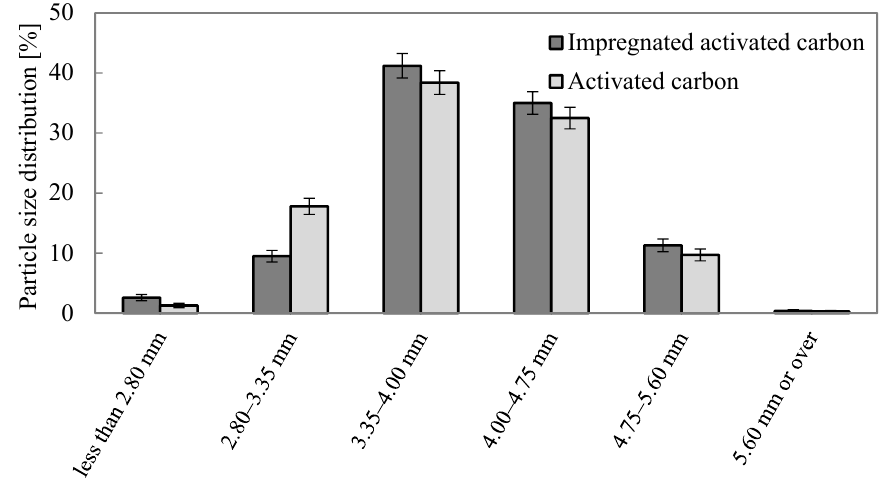
Figure 3. The particle size distribution of impregnated activated carbon. Table 2. Characteristics of impregnated activated carbon and activated carbon. Impregnated Characteristics